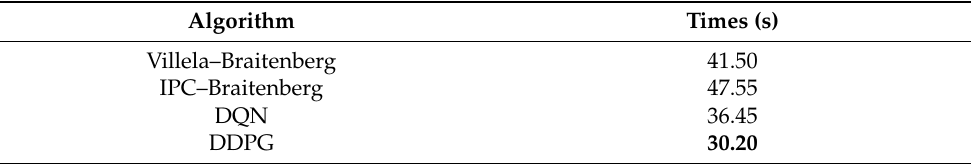
Table 3. Time to reach the target point for the experiment with an obstacle.